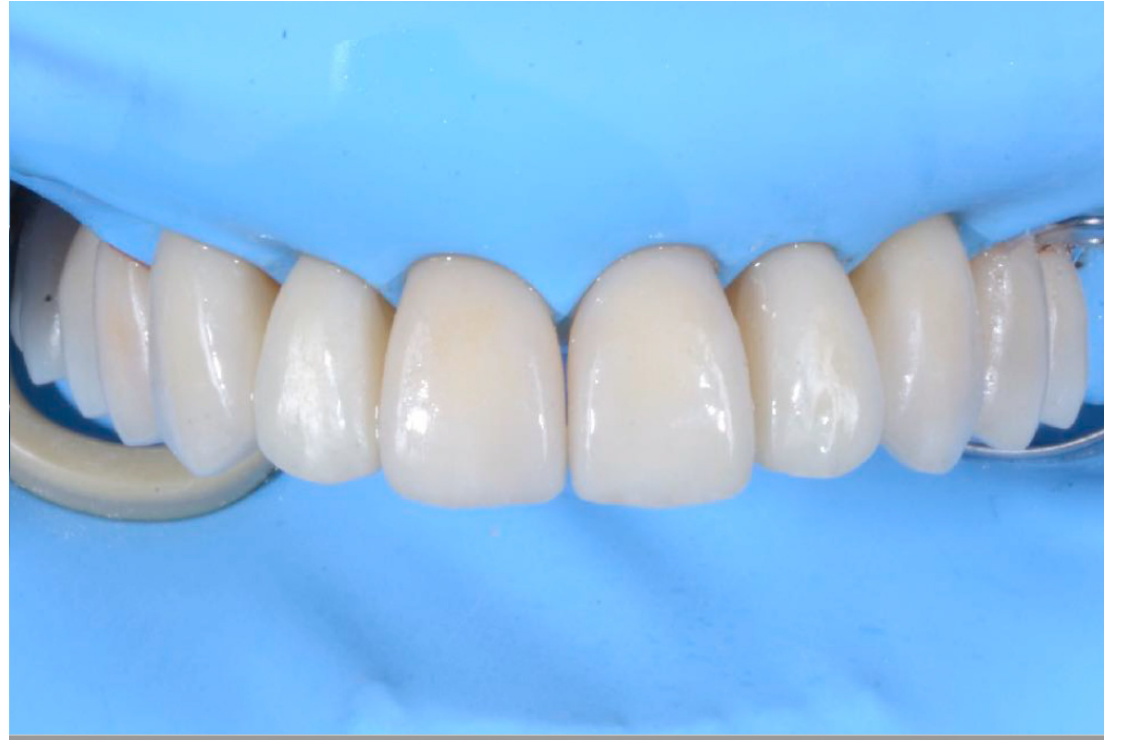
Figure 10. Adhesive cementation of prosthetic artifacts (overlays, onlays, and veneers) using an adhesive technique, dry field.